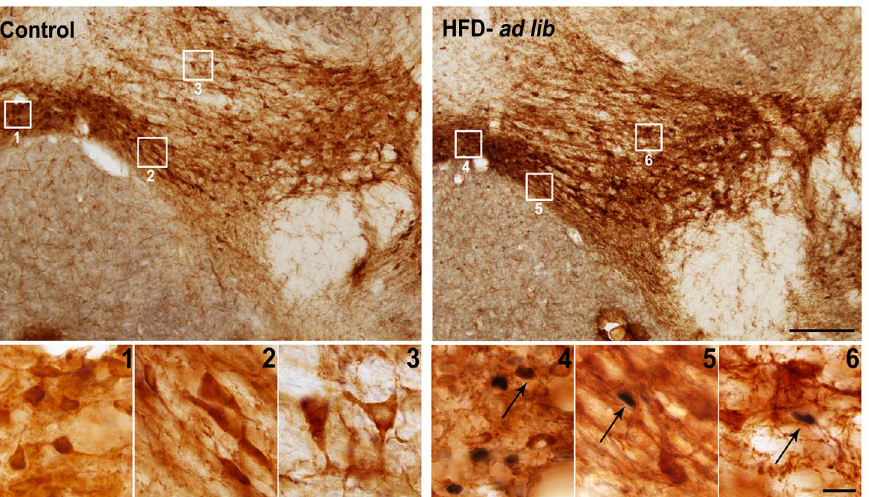
Figure 4. Acute HFD activates c-Fos in TH-IR neurons of specific sub-regions of the VTA. Panels show representative photomicrographs of brain sections subjected to double immunohistochemistry using anti-TH (brown staining) and anti-c-Fos (purple/black staining) antibodies. Left and right panels show low magnification images from a mouse of control and HFD- ad lib group, respectively. Panels 1 to 6 show in higher magnification the areas marked in low magnification images. Panels 1 and 4 show the IF, panels 2 and 5 show the PN, and panels 3 and 6 show the PBP sub-region